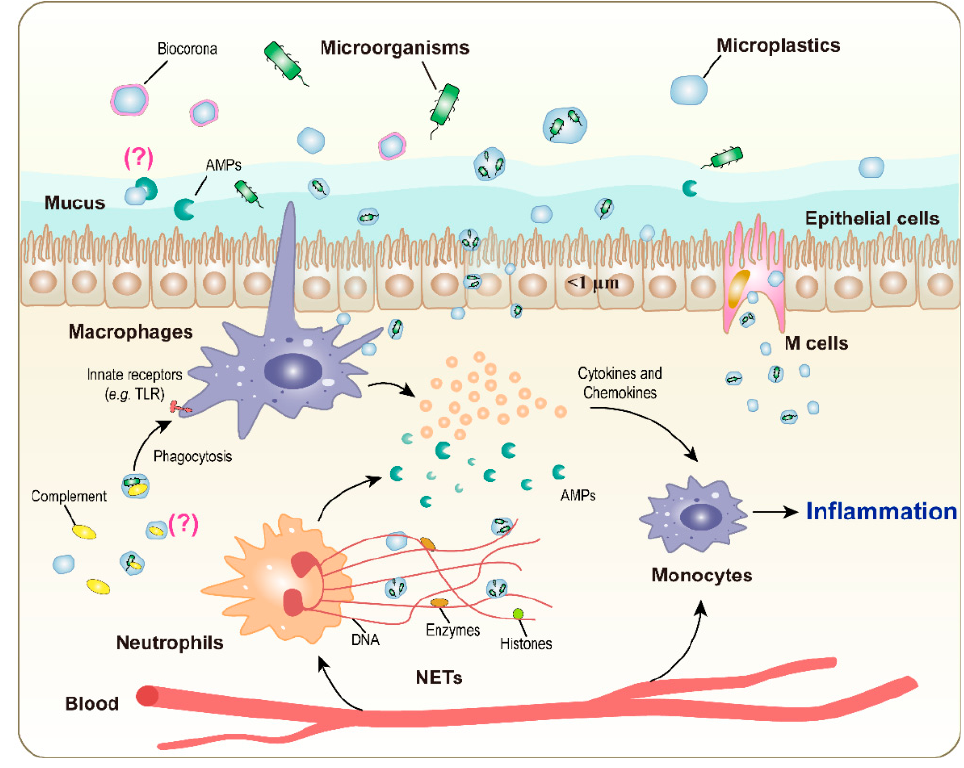
Figure 2. Ways of interaction of the immune system with microorganisms complexed with microplastics at a mucosal site.